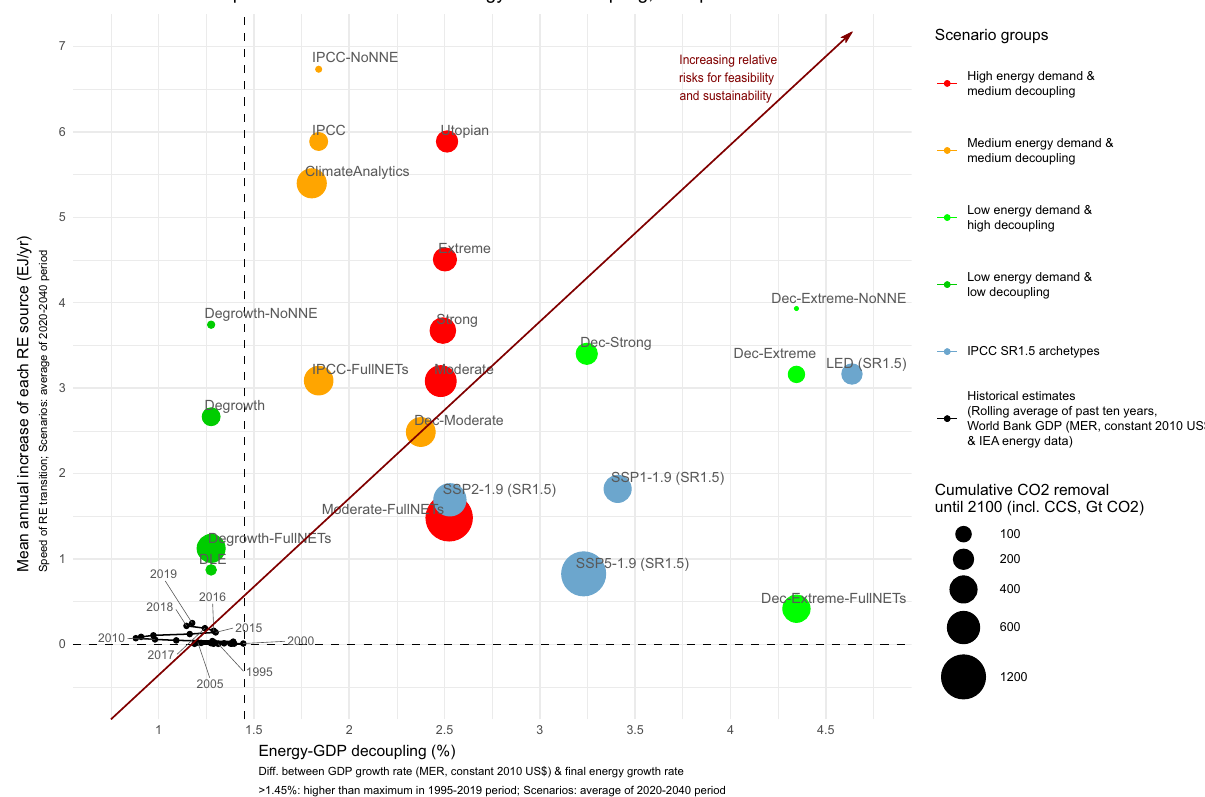
Fig. 5 1.5 °C scenario map under different levels of energy-GDP decoupling, RE speed and NETs. The dimensions are ‘ speed of renewable energy transition ’ (for the scenarios the 2020 – 2040 annual average growth in solar, wind and other renewables, in EJ/yr), ‘ energy-GDP decoupling ’ (for the scenarios the 2020 – 2040 average difference between GDP growth rate and fi nal energy growth rate, in %) and cumulative CO 2 removal until 2100, including CCS (GtCO 2 ). Historical data points are the rolling averages of the past ten years (e.g., for the 1995 point the period 1986 – 1995) of the respective indicators. This averaging was chosen (1) because GDP and fi nal energy data are noisy and (2) to emphasise longer-term trends. While historically four years were above a decoupling of 2% since 1986, these are outlieres around a lower, almost constant trend 8 . Historical GDP data (MER, constant 2010 US $) is taken from the World Bank. The conceptually equivalent graph for 2 °C can be found in Supplementary Fig.